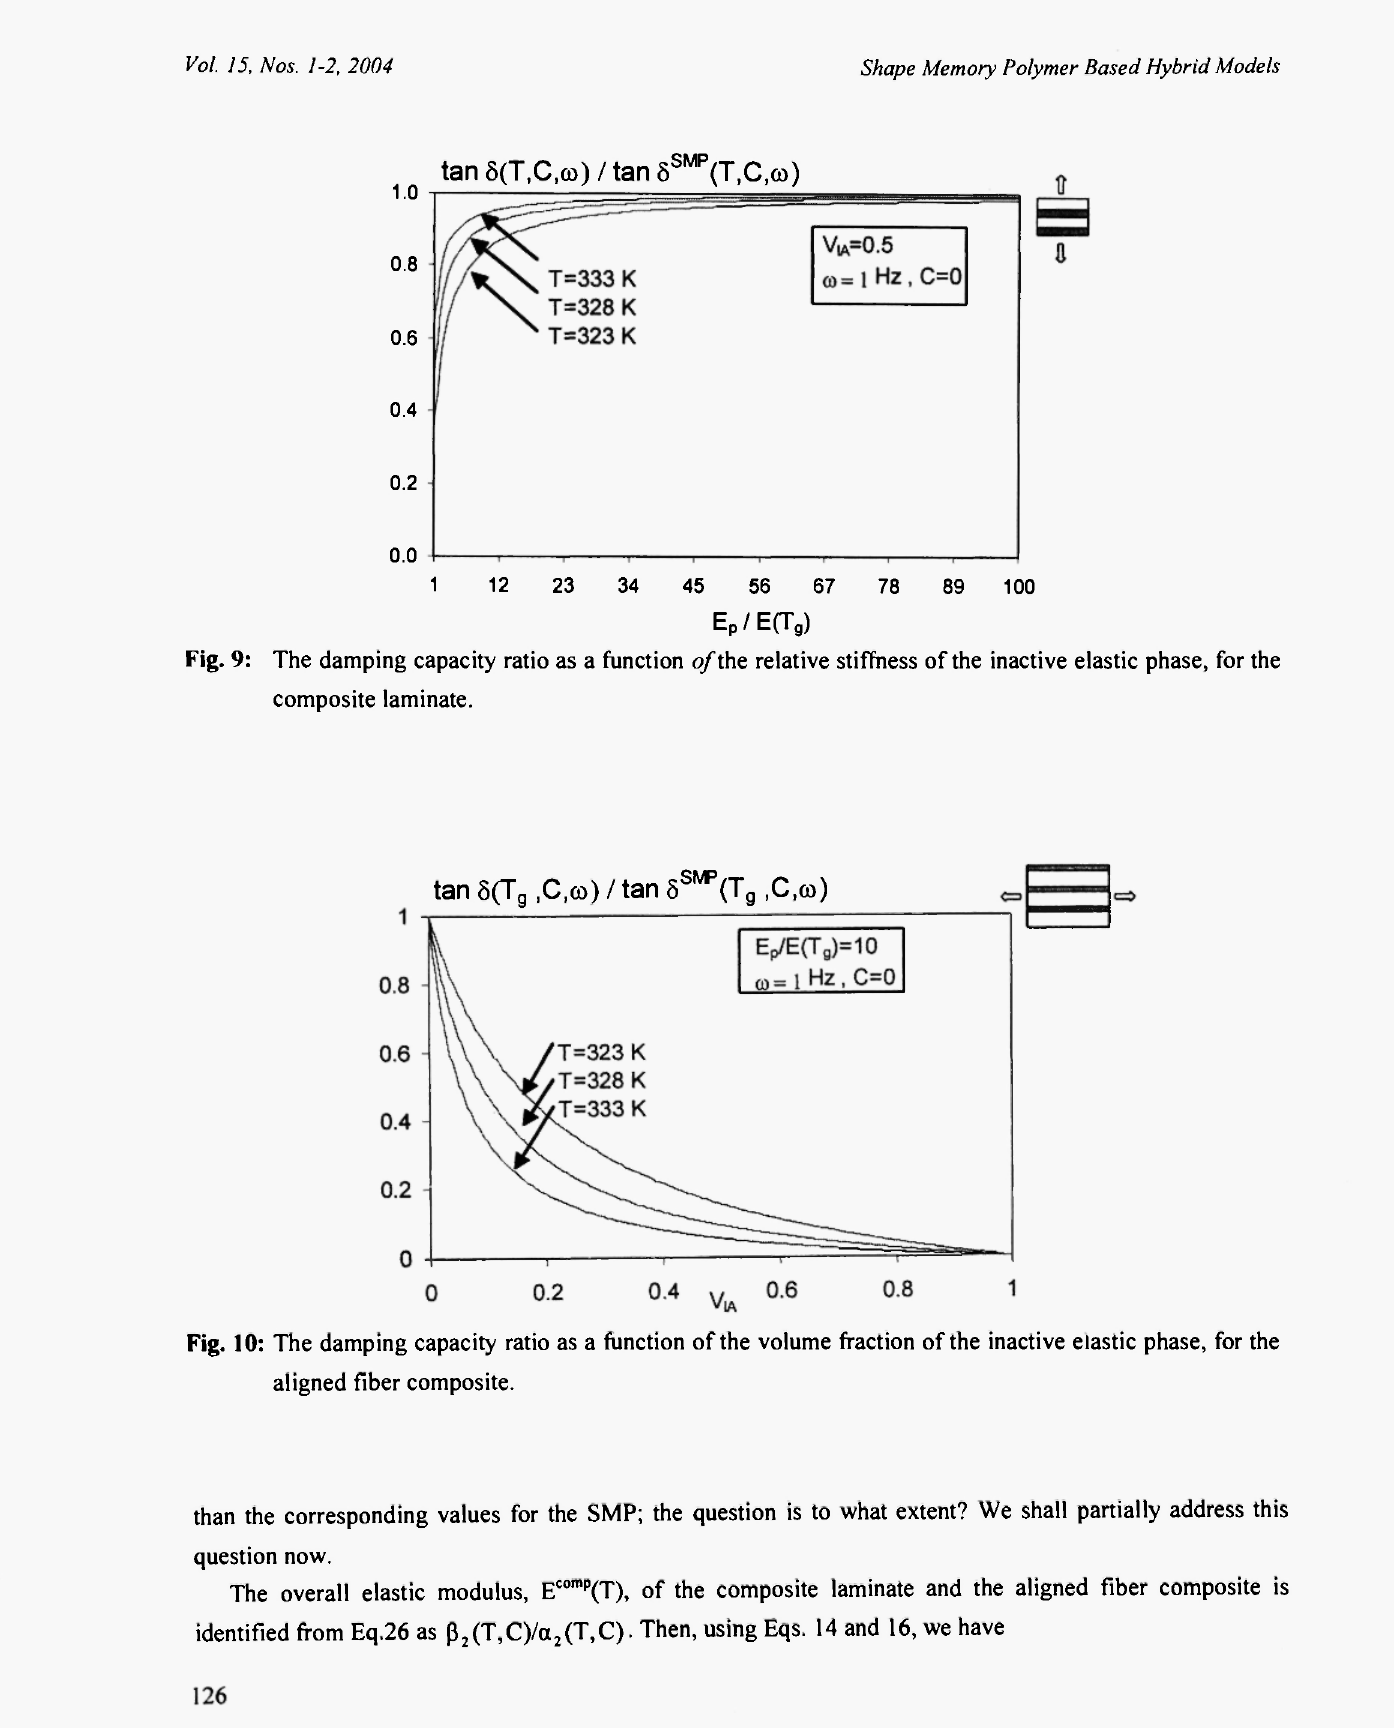
Fig. 10: The damping capacity ratio as a function of the volume fraction of the inactive elastic phase, for the aligned fiber